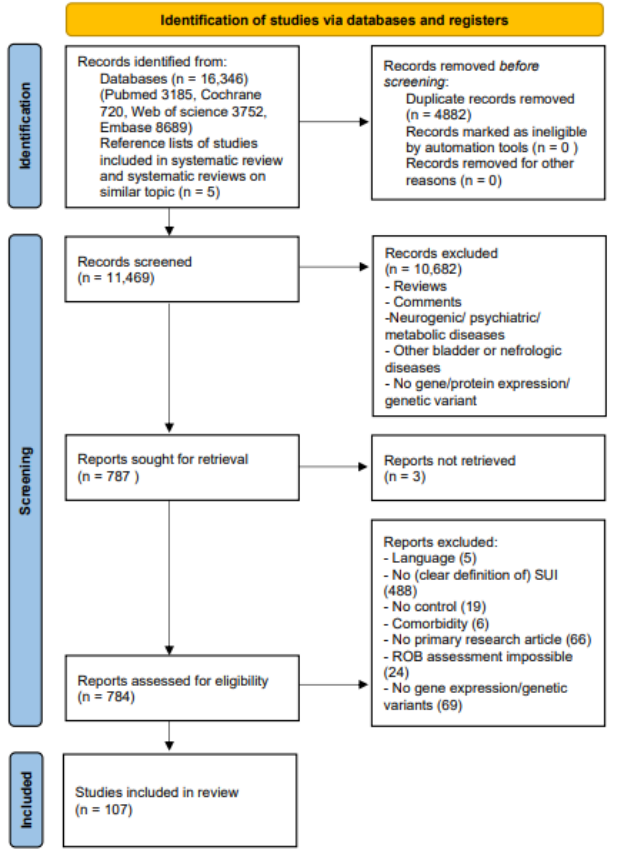
Figure 1. Prisma flow chart [21]. Systematic selection of articles and main reasons for exclusion based on the Prisma 2020 statement. Abbreviations: SUI stress urinary incontinence, ROB risk of bias.